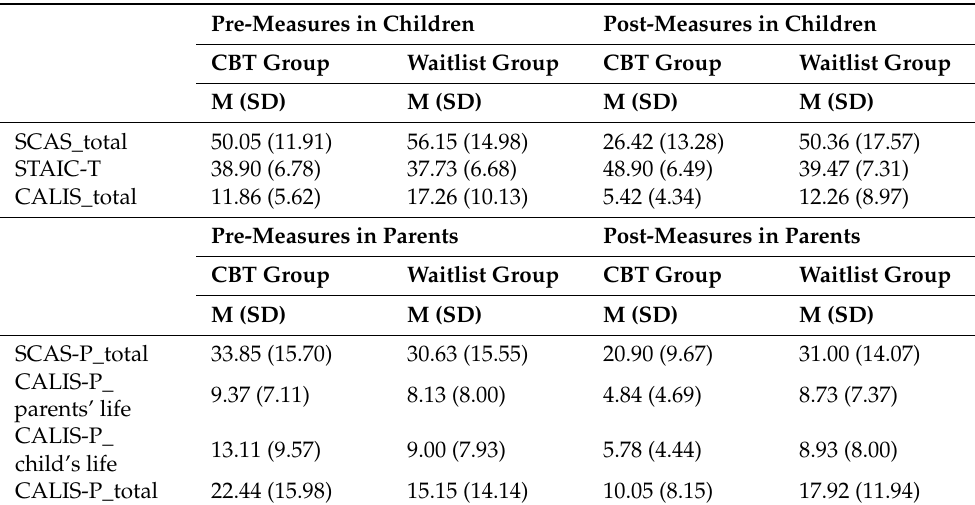
Table 2. Pre- and post-measures for CBT and WL groups for children and parents. Pre-Measures in